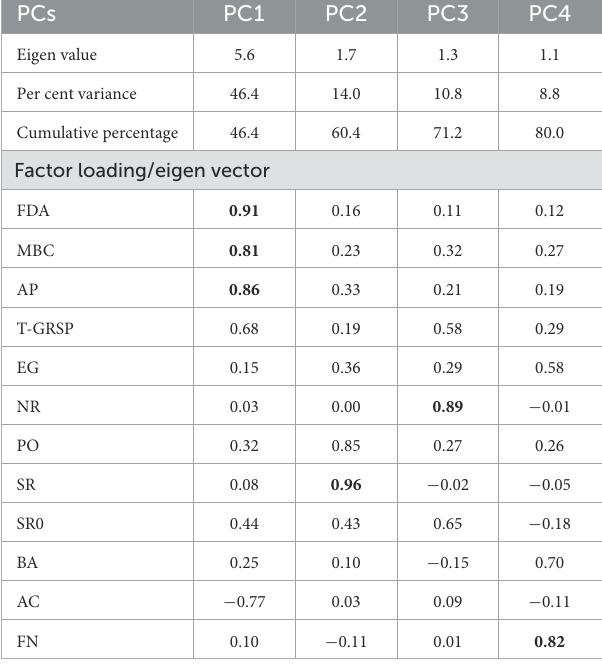
TABLE 2 Performance of soil biological indicators in terms of factor loading/eigen vector values in principal component